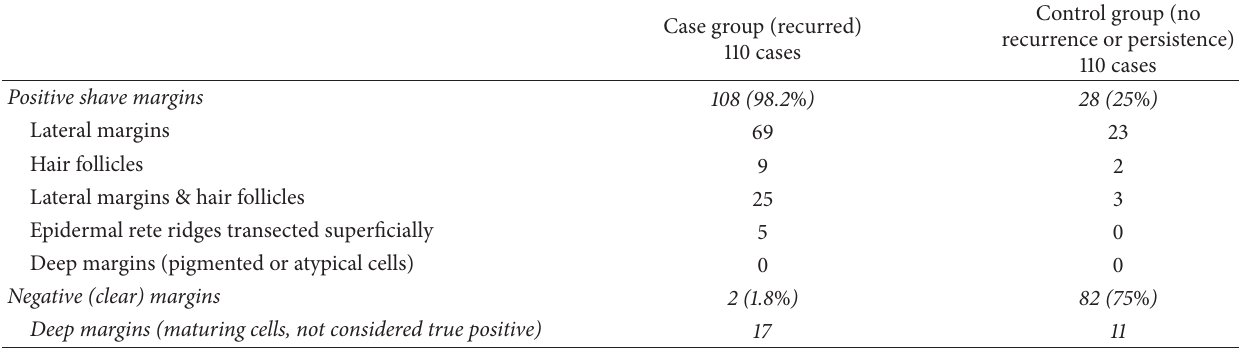
Table 1: Excision specimens with recurrence compared with the original shave removal specimens.